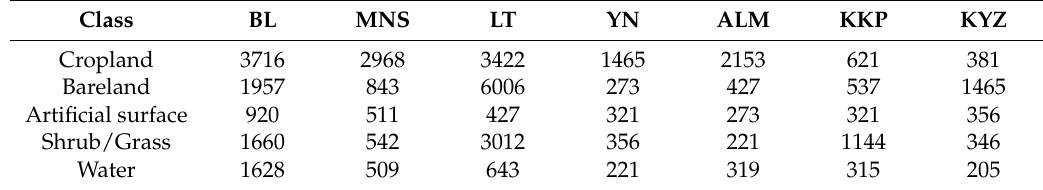
Figure 4. Exemplary training samples and corresponding NDVI signatures from Landsat images. The NDVI color is presented as R: NDVI in September of 2016; G: NDVI in July of 2016; B: NDVI in May of 2016. Note: We collected polygons based on very high resolution (VHR) images and visually interpreted these samples using both Landsat NDVI time series and the VHR image, and finally converted the polygons to Landsat pixels. These samples are pure pixels as they were collected in homogenous regions based on the VHR images. Table 3. Number of training samples (pixels) for different land cover types in seven test